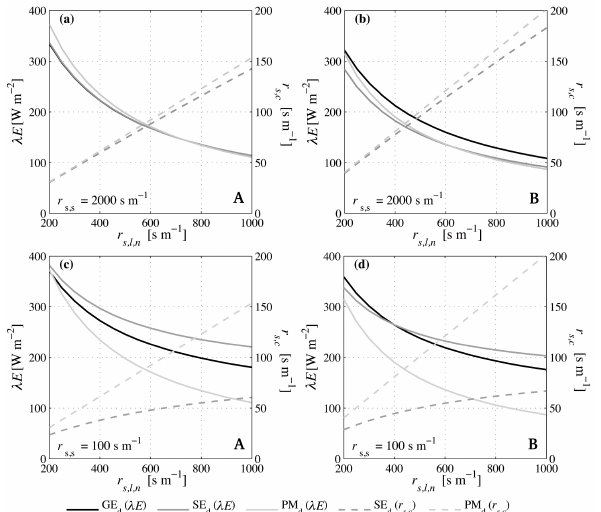
Fig. 4. Latent heat flux ( λE) from a partially wet canopy as a func- tion of its fractional surface wetness ( W) . Comparison of two for- mulations (GE w and PM w ) for two profiles of leaf area density ( A and B ) and two different values of minimal stomatal resistance r s,l,n representing canopy water stress: (a) and (b) r s,l,n = 100sm − 1 (un- stressed canopy); (c) and (d) r s,l,n = 1000sm − 1 (stressed canopy). Soil surface resistance r ss is set to 500sm − 1